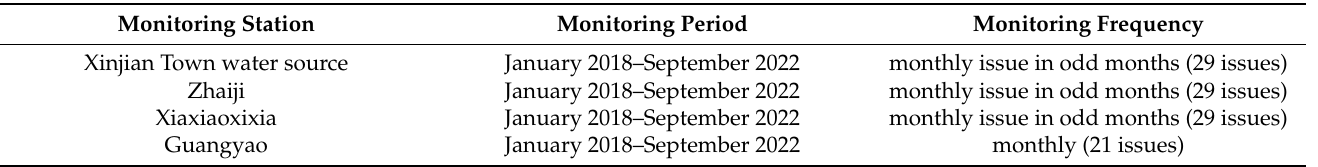
Table 1. Frequency of water quality monitoring in the Xinjian River.